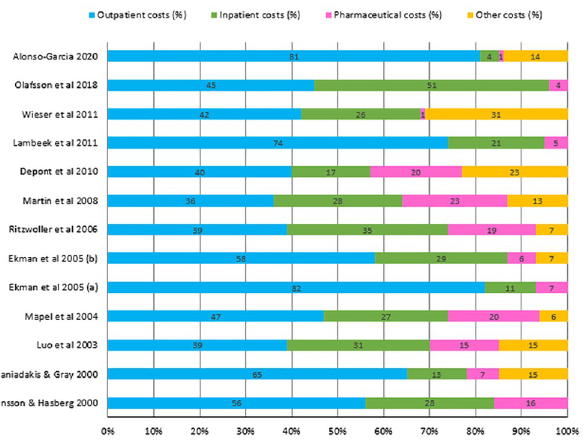
Fig 2. Allocation of direct costs in COI studies of back pain. Legend: The figure illustrates the allocation of direct costs in studies that reported on all three major costs components (inpatient, outpatient, and pharmaceutical costs) of direct costs.